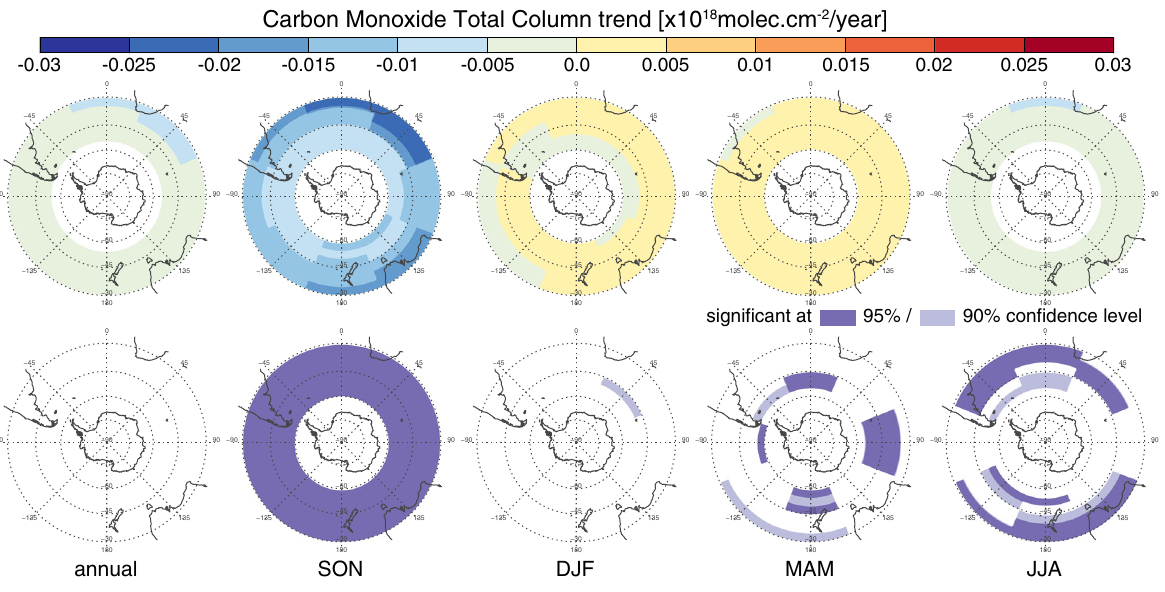
Fig. 8 Spatial distribution of linear trends (top, ×10 18 molecule cm − 2 year − 1 ) and p values (bottom) for deseasonalized CO results in the Southern Hemisphere (30 – 60° S) from 2005 to 2016. The first column shows the annual trend; other columns show seasonal trends. The regions showing statistically significant trends are colored deep purple ( p < 0.05) or light purple ( p < 0.10)